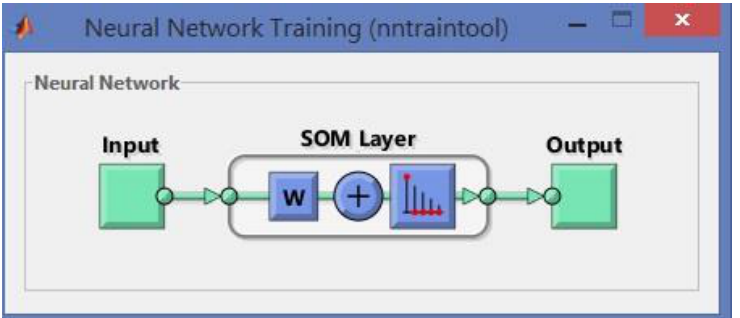
Figure 6. SOM layout using the GUI toolbox in MATLAB.